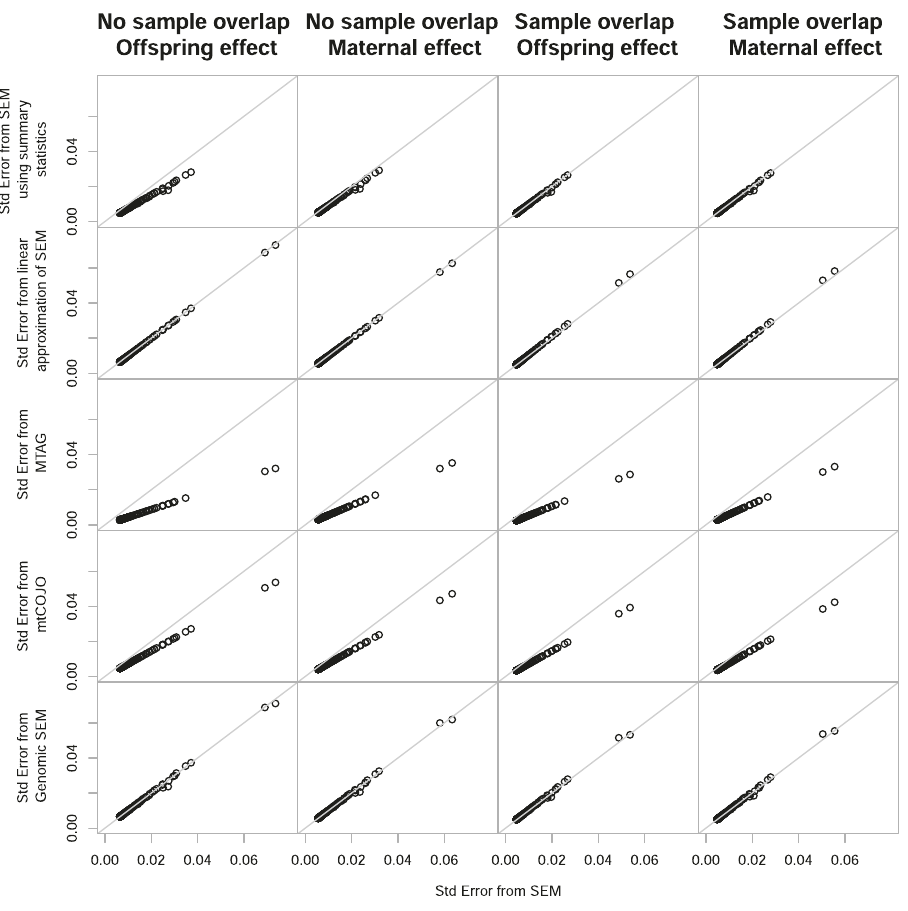
Fig. 2 Comparison of the standard error from the SEM using individual level data ( x -axis) and the various different methods using the summary statistics from the GWAS of own and offspring birth weight ( y -axis) for the 300 autosomal genome-wide signi fi cant SNPs from Warrington et al. 3 . The columns summarize the results from the analysis including unique individuals in the GWAS of own and offspring birth weight for the offspring and maternal genetic effect, respectively, followed by the results from the analysis where there were overlapping samples in the GWAS of own and offspring birth weight for the offspring and maternal genetic